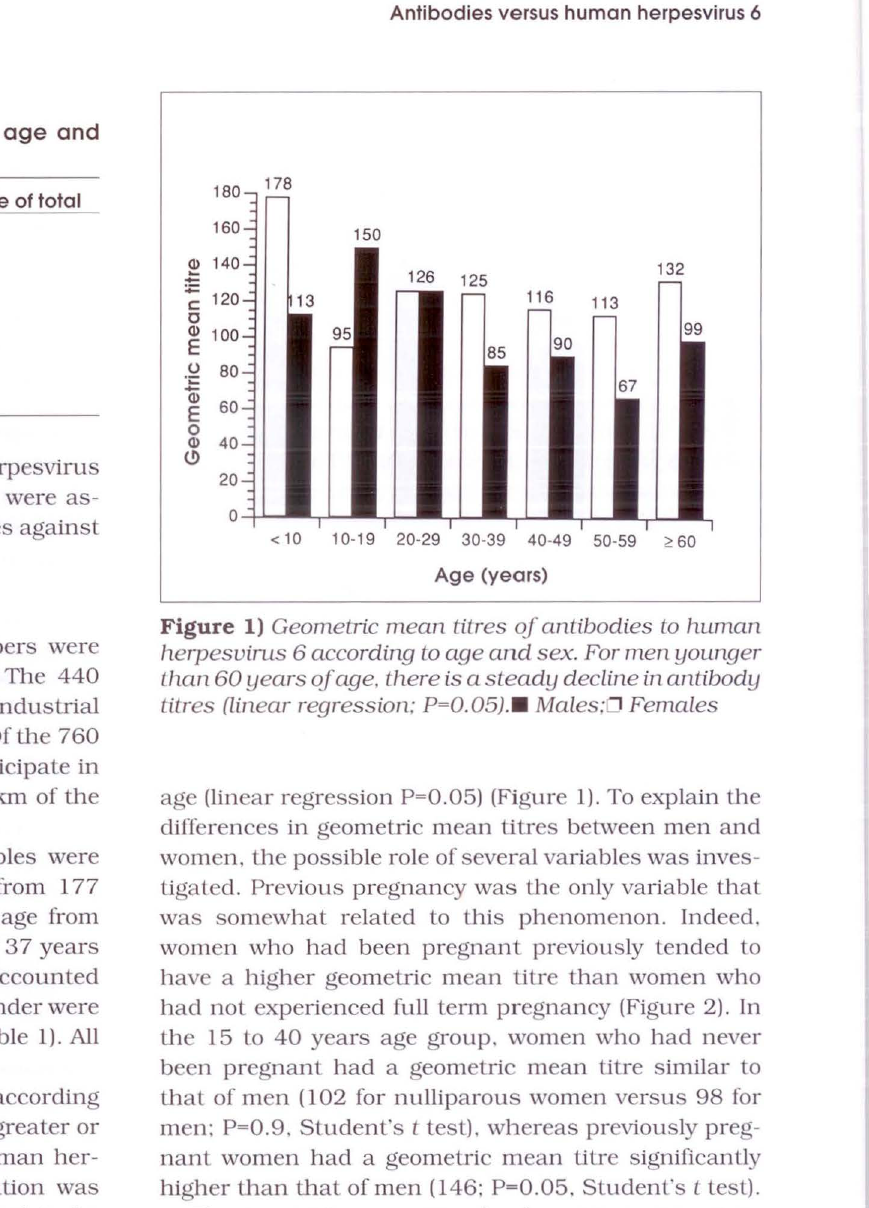
Figure I) Geometric mean iitres of antibodies to human herpesvinLS 6 according to age and sex. For men younger ihan 60 years of age, there is a steady decline in antibody litres {linear regression: P=0.05J.• Males: Females